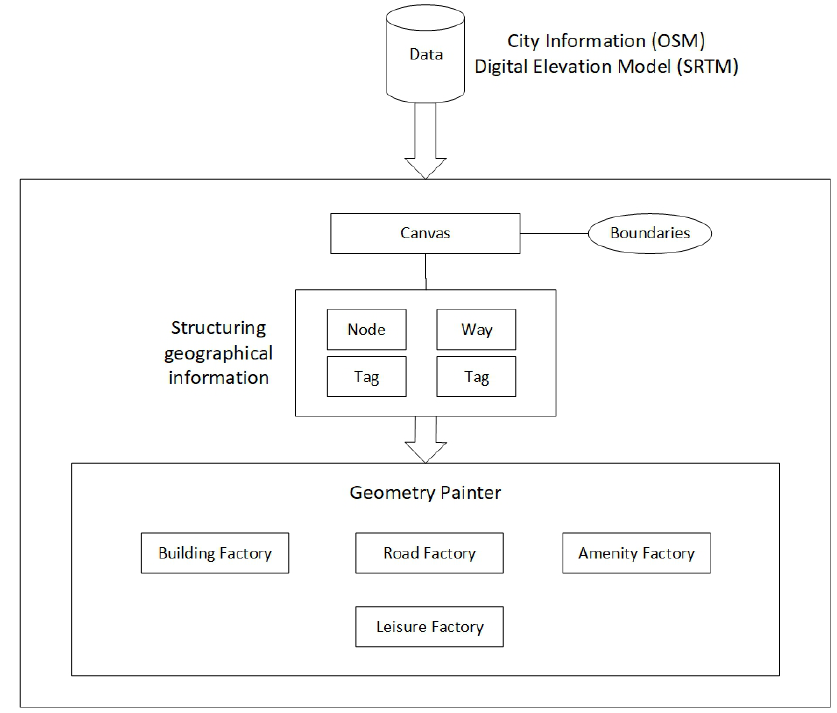
Figure 2. Parts of feature extraction and drawing hierarchy of City